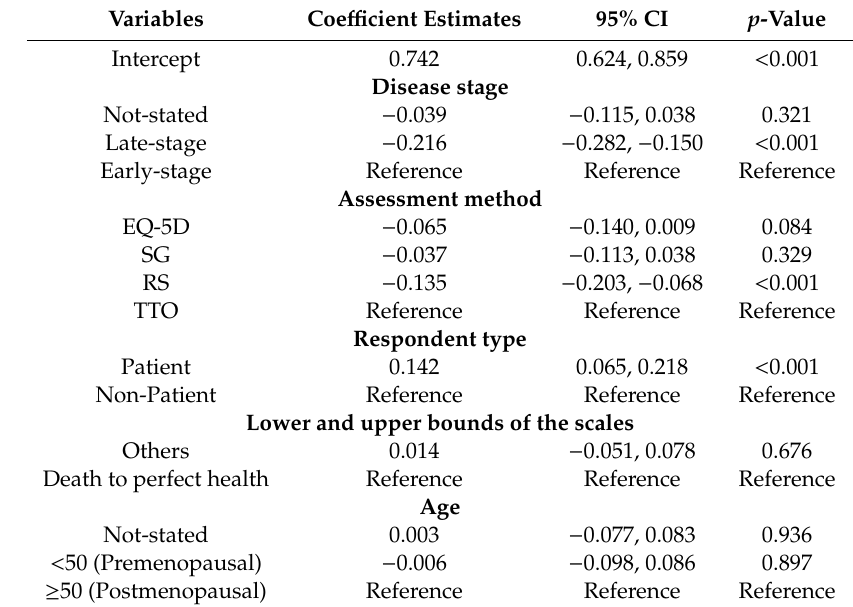
Table 3. The result of the HLM model ( n = 224): coe ffi cient estimates, p -values, and 95% confidence intervals (CI) for the predictors of